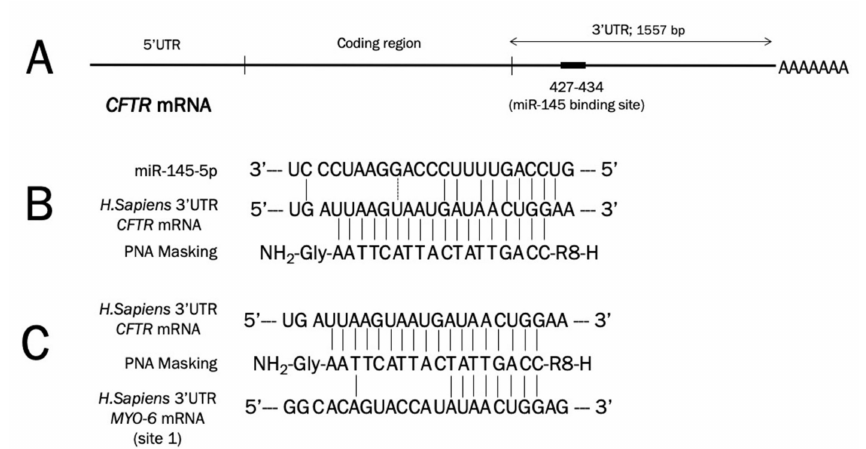
Figure 2. ( A ). Location of the miR-145-5p binding sites within the cystic fibrosis